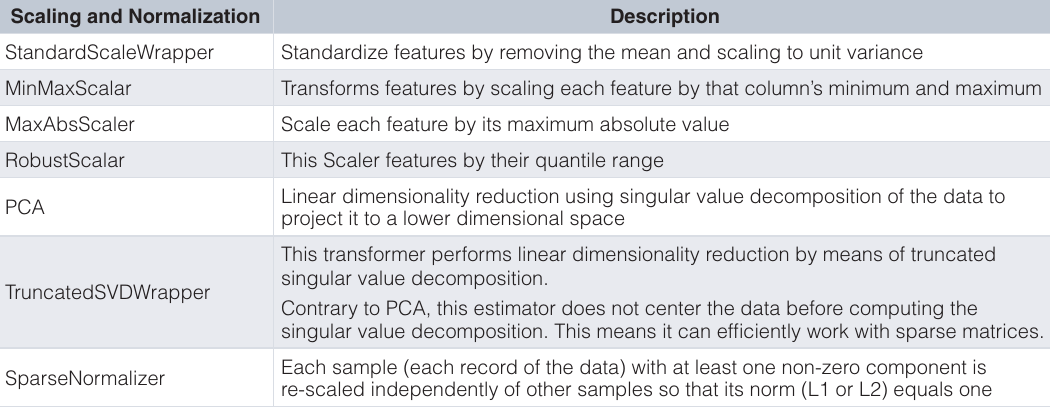
Table 14. Scaling function information for machine learning model search 31 . Scaling and